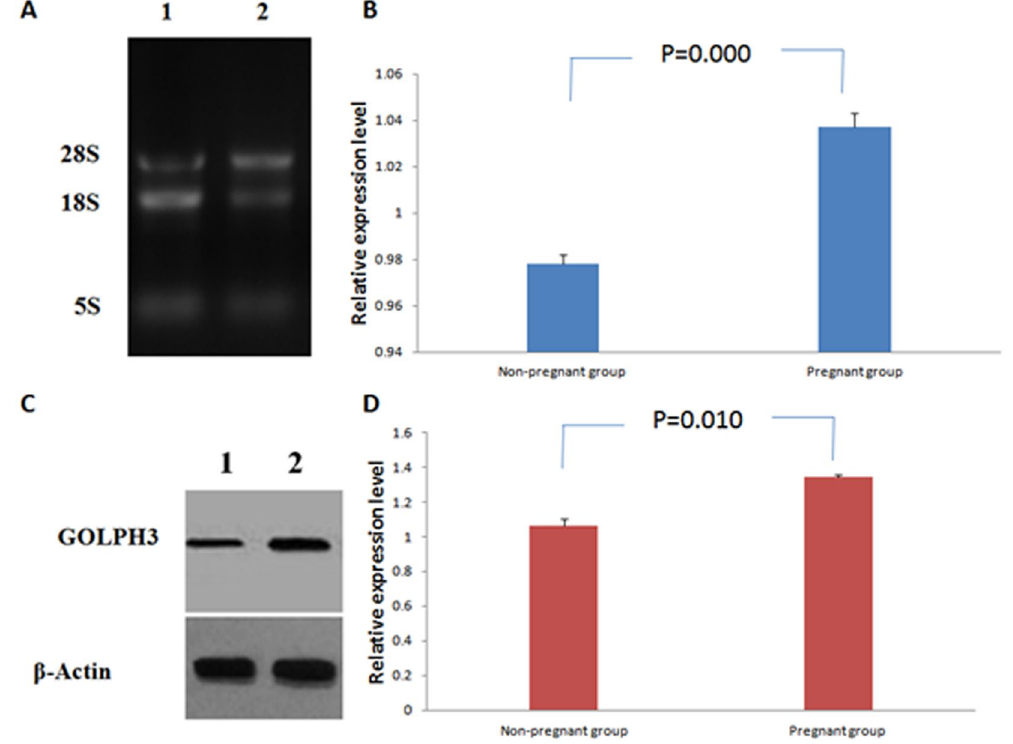
Figure 4. qRT-PCR and Western blotting assays detect GOLPH3 expression in cumulus granulosa cells. ( A ) Agarose gel electrophoresis of total GOLPH3 RNA. 1, Non-pregnant group; 2, Pregnant group; ( B ) Comparison of relative GOLPH3 mRNA expression in cumulus granulosa cells between the pregnant- and non-pregnant groups; ( C ) Western blotting analysis detects GOLPH3 protein expression in cumulus granulosa cells, and β -actin serves as a loading control. 1, Non-pregnant group; 2, Pregnant group; ( D ) Comparison of GOLPH3 protein expression in cumulus granulosa cells between the pregnant- and non-pregnant